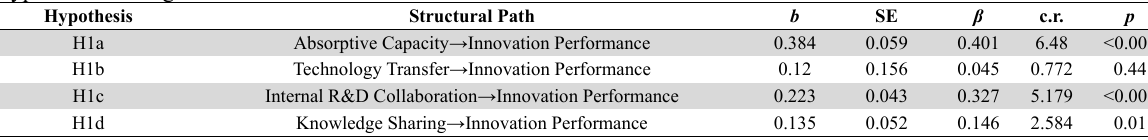
Hypothesis Testing Result Hypothesis Structural Path